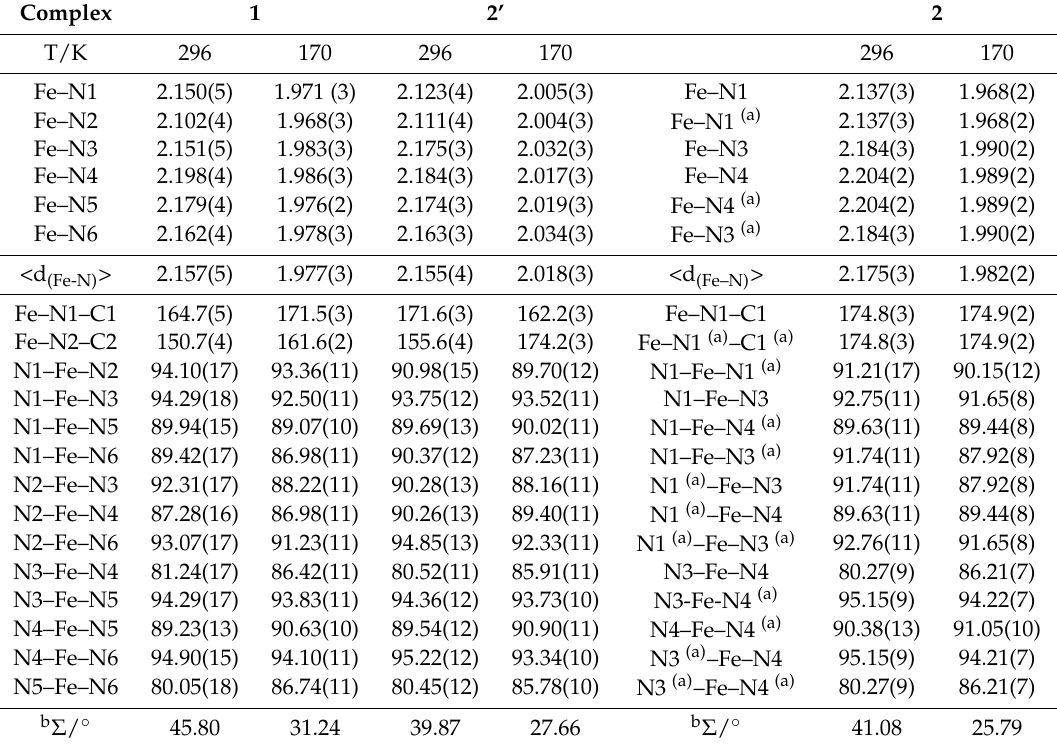
Table 1. Selected bond lengths (Å) and bond angles ( ◦ ) and the Σ distortion parameters for the complexes 1 , 2, and 2’